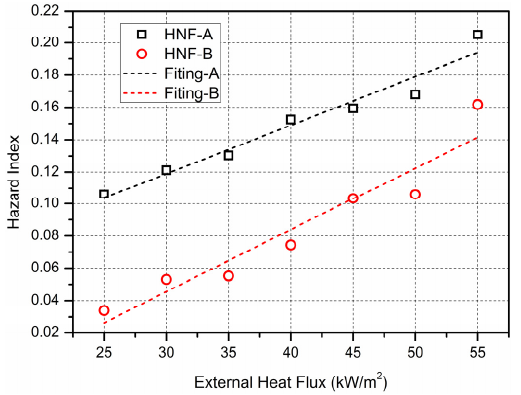
Figure 15. HNF model of fire hazard for material A and B.